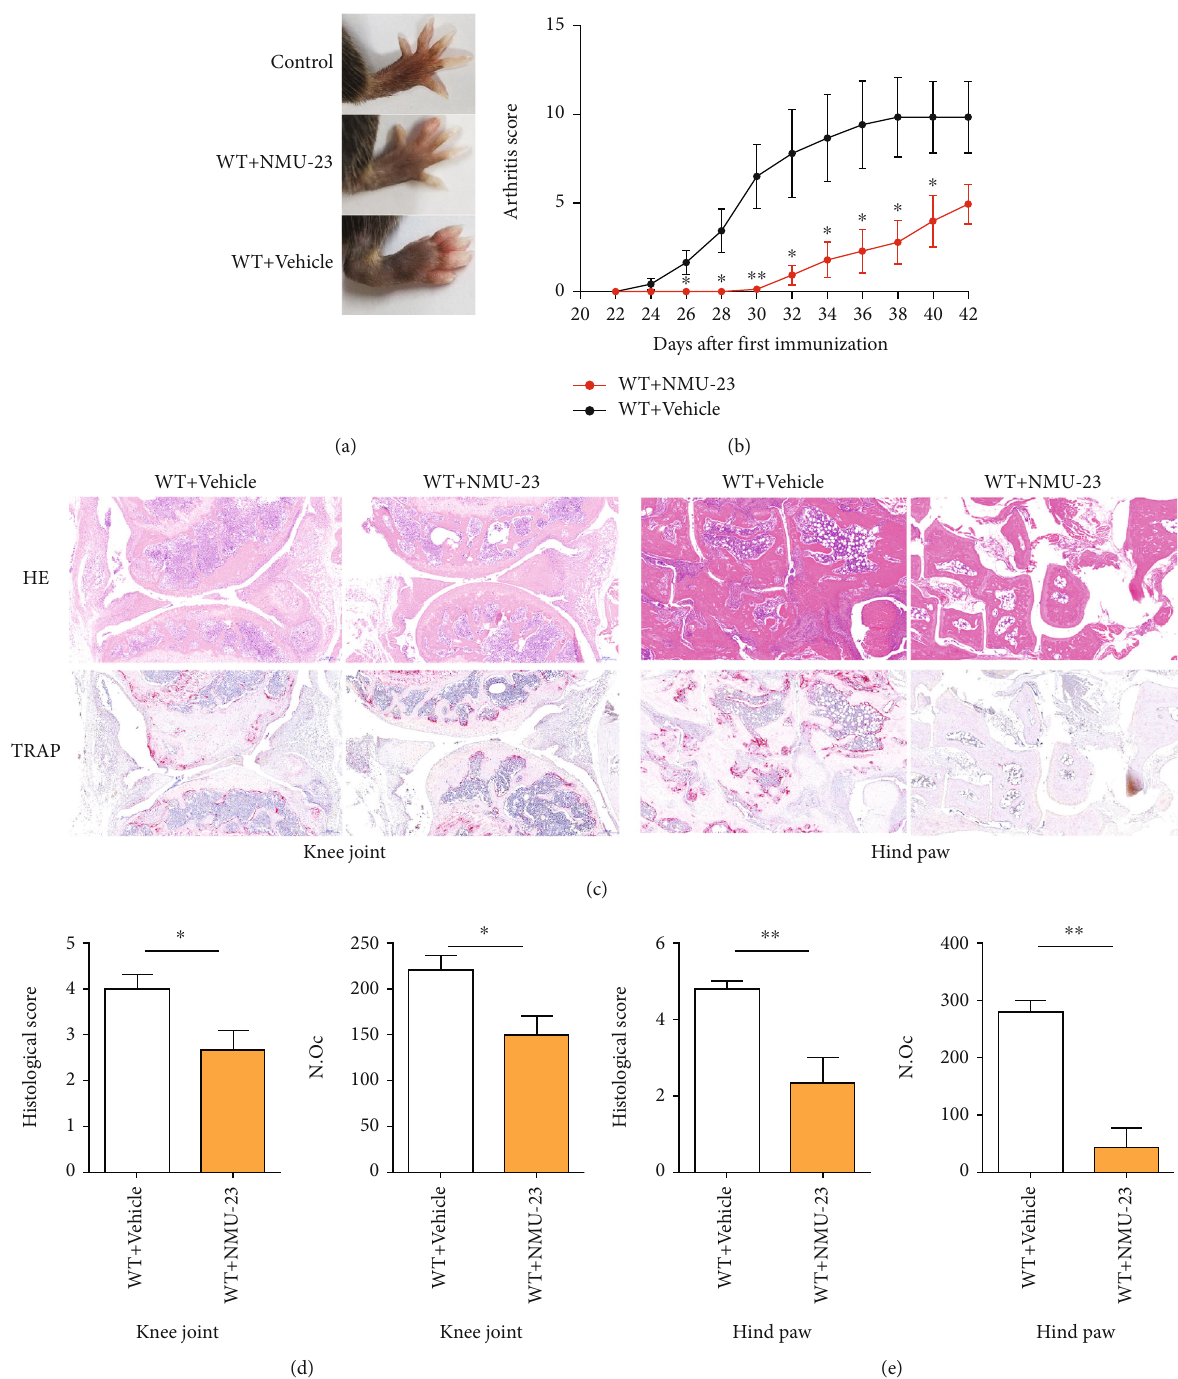
Figure 1: NMU-23 inhibited joint in fl ammation and bone erosion in CIA mice. (a) Representative hind paw of mice from WT control ( n = 3 ), WT treated with NMU-23 ( n = 8 ), and WT treated with PBS ( n = 8 ). (b) Clinical assessment of CIA mice determined every 2 days ( n = 8 each in two independent experiments). (c) Representative hematoxylin-eosin (H&E) and tartrate-resistant acid phosphatase (TRAP) staining of the knee joint and hind paw of mice. (d, e) Quanti fi cation of histological score and number of osteoclasts in the knee joint (d) and hind paw (e) of mice. Data are shown as mean ± SEM ( ∗ P < 0 : 05 and ∗∗ P < 0 : 01 determined by Student ’ s t